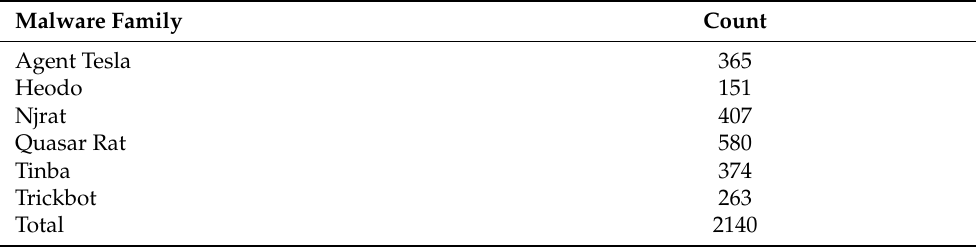
Table 1. Composition of Data Set